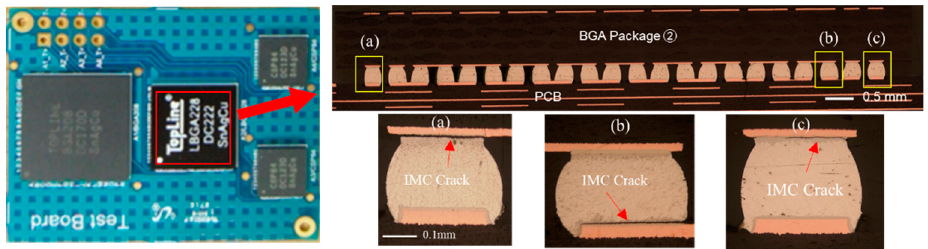
Figure 9. Failure analysis of the BGA package ② . (a) crack failure between Package and BGA, (b) crack failure between BGA and PCB, (c) crack propagating between Package and BGA.